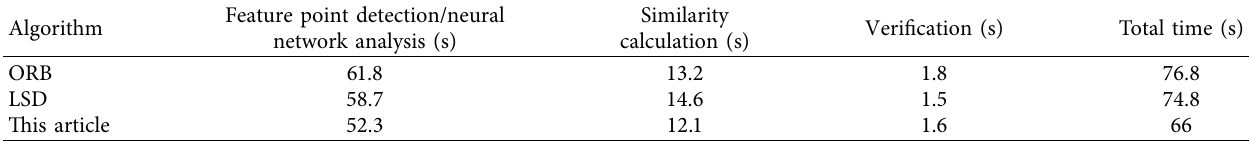
Table 2: Time-consuming analysis of three